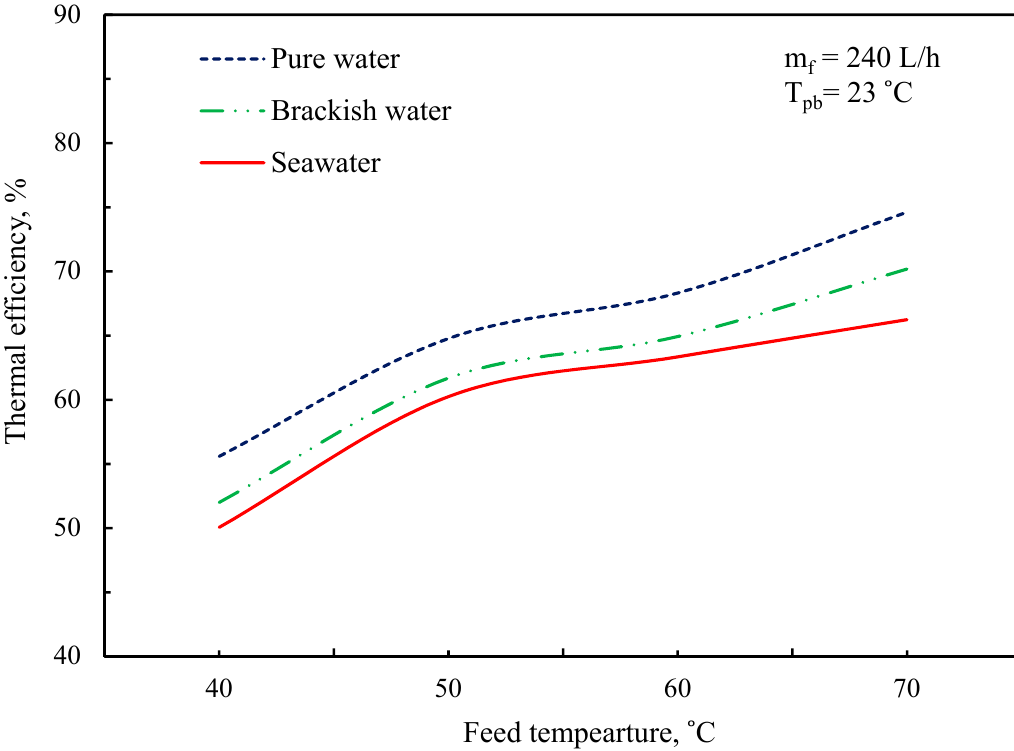
Figure 14. Influence of feed temperature on the thermal efficiency.